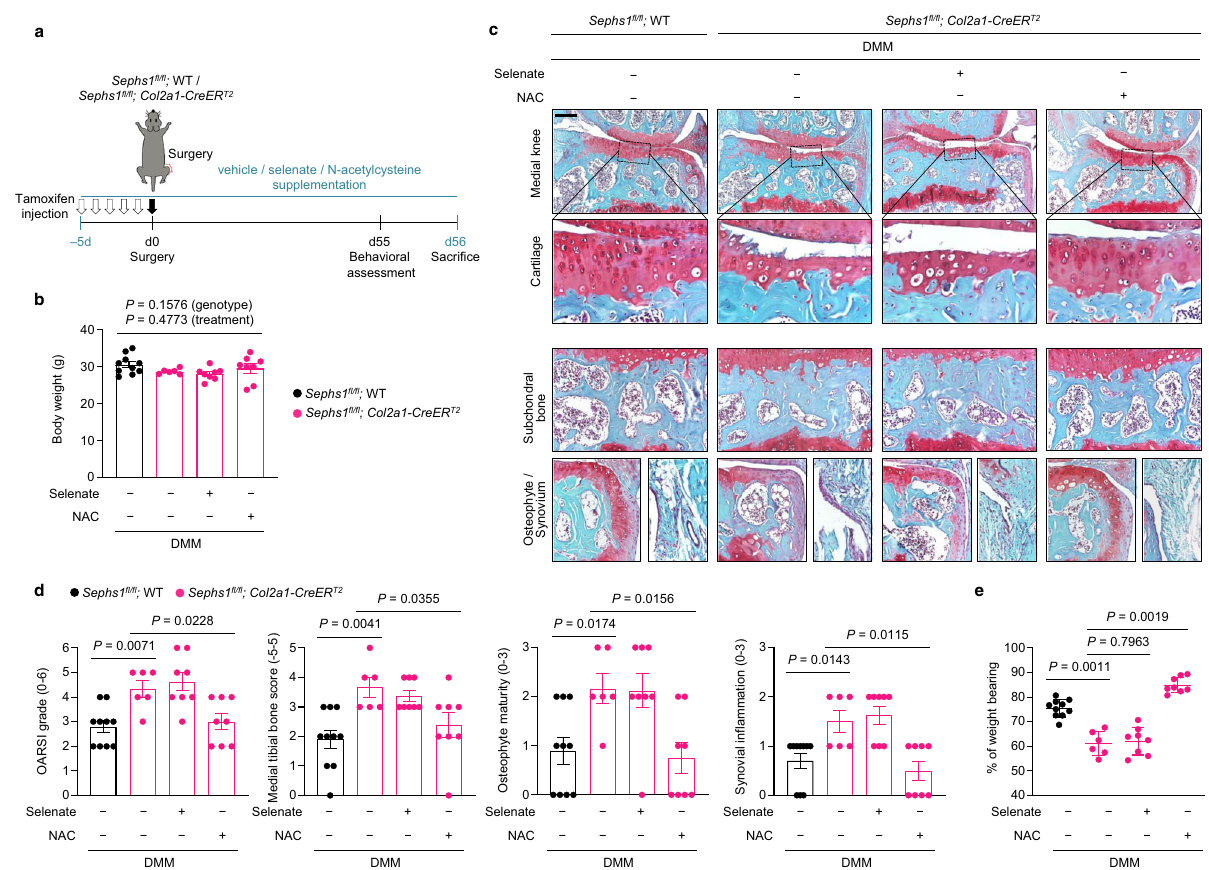
Fig. 5 NAC treatment rescues the exacerbated OA phenotypes in Sephs1 -iCKO mice. a Schematic illustration of NAC or dietary selenate supplementation in the post-traumatic OA model of Sephs1 -iCKO mice. b Body weight of 21-week-old DMM-operated mice after completion of the supplementation scheme ( n = 10 for DMM-operated WT mice treated with vehicle; n = 6 for DMM-operated Sephs1 -iCKO mice treated with vehicle; n = 8 for DMM-operated Sephs1 -iCKO mice supplemented with selenate; n = 8 for DMM-operated Sephs1 -iCKO mice treated with NAC). c Joint sections were stained with safranin O, fast green, and hematoxylin. The inset in the images is shown as magni fi ed images in the bottom row. d Cartilage destruction, subchondral bone sclerosis, osteophyte formation, and synovial in fl ammation determined by safranin O/hematoxylin staining and scored ( n = 10, 6, 8, 8 respectively). e The percentage of weight placed on the DMM-operated limb versus the contralateral limb of WT and Sephs1 -iCKO mice treated with or without NAC or selenate determined using a static weight bearing test ( n = 10, 6, 8, 8 respectively). Scale bar: c 200 μ m. b , d , e Data represent means ± s.e.m. P values are from two-way ANOVA followed by Tukey ’ s post hoc test ( b ) or S – R – H test followed by Mann – Whitney U test ( d , e ). Cohen ’ s d effect sizes are provided in Supplementary Table 8. Mankin scores and SBP thickness measurements are provided in Supplementary Figs. 11 and 12.